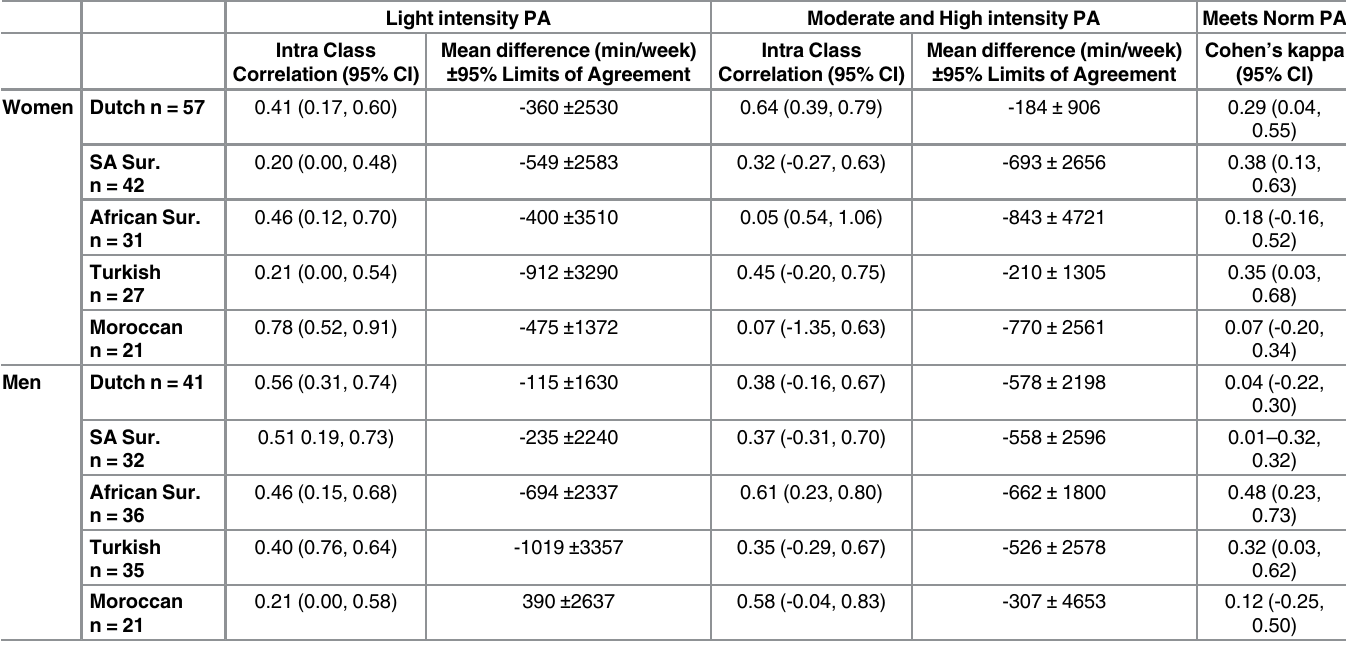
Table 2. Test-re-test reliability of the SQUASH